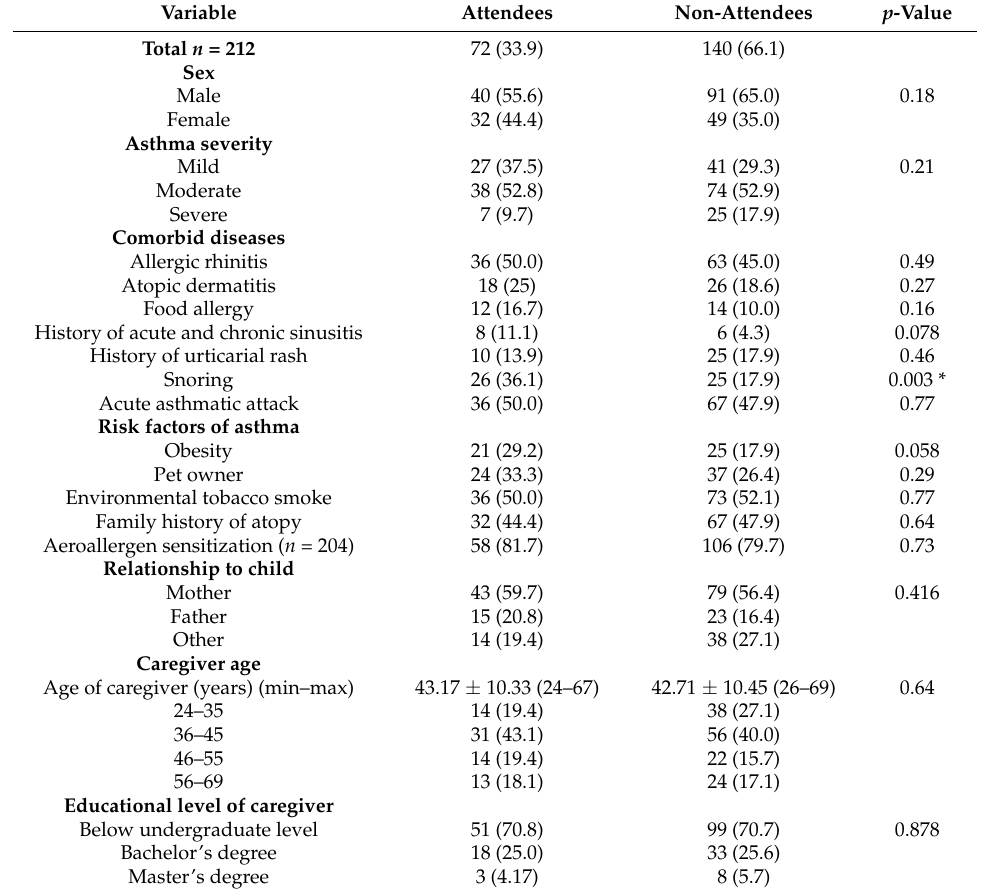
Table 1. Demographic data at baseline for patients who attended/did not attend an asthma education